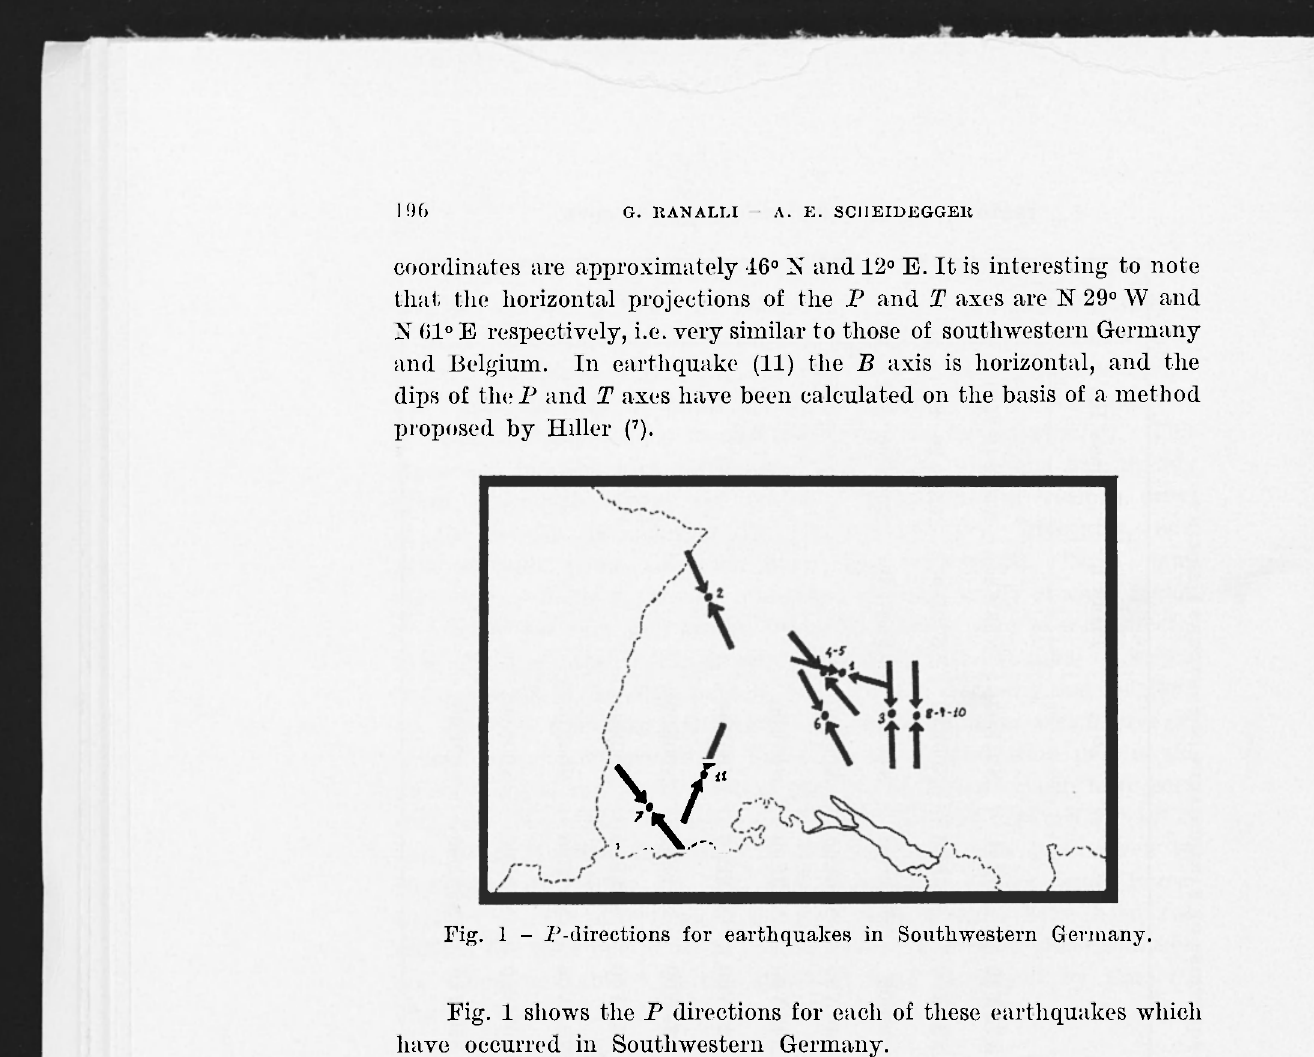
Fig. 1 shows the P directions for each of these earthquakes which have occurred in Southwestern